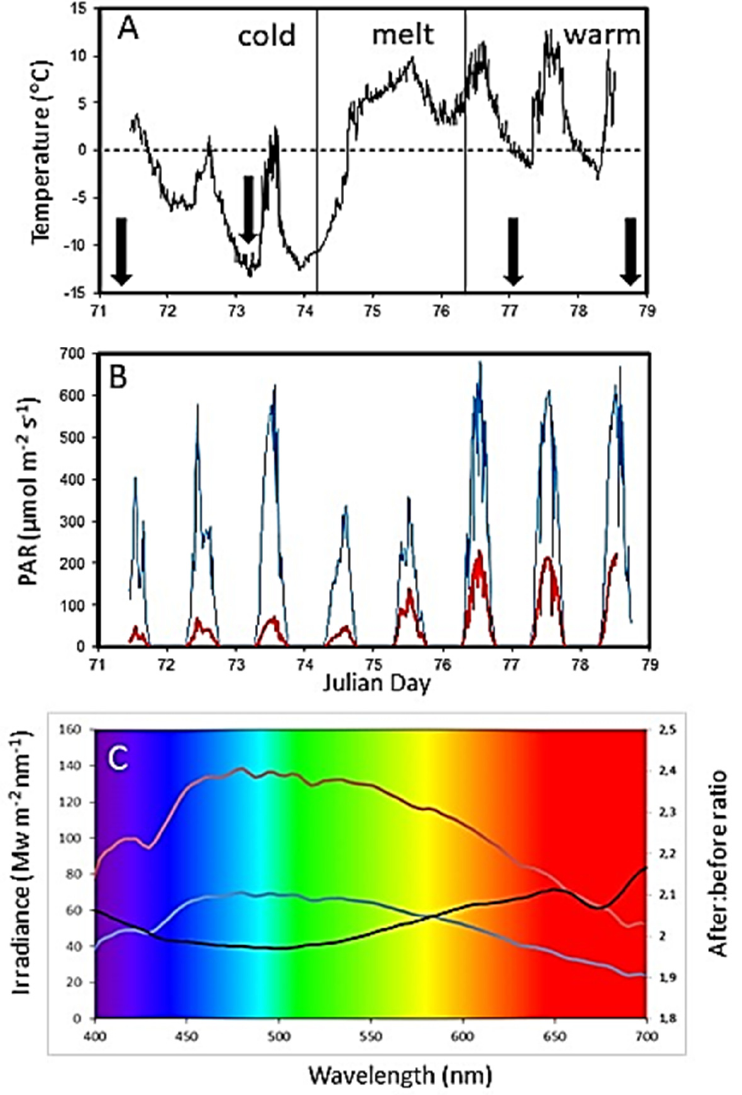
Figure 3. Time series at the sea ice station of ( A ) air temperature and ( B ) irradiance (photosynthetically active radiation, PAR) at the ice surface (blue) and under-ice (red). The periods of cold, snow-covered ice, melting snow during the storm event, and post-snowmelt warm ice are shown in ( A ), with black arrows marking the sampling events (Days 71 and 73 with snow cover, Days 77 and 78 without snow cover). ( C ) Spectral irradiance under the ice before (blue line) and after (red line) snowmelt. The black line is the ratio of irradiance without:with